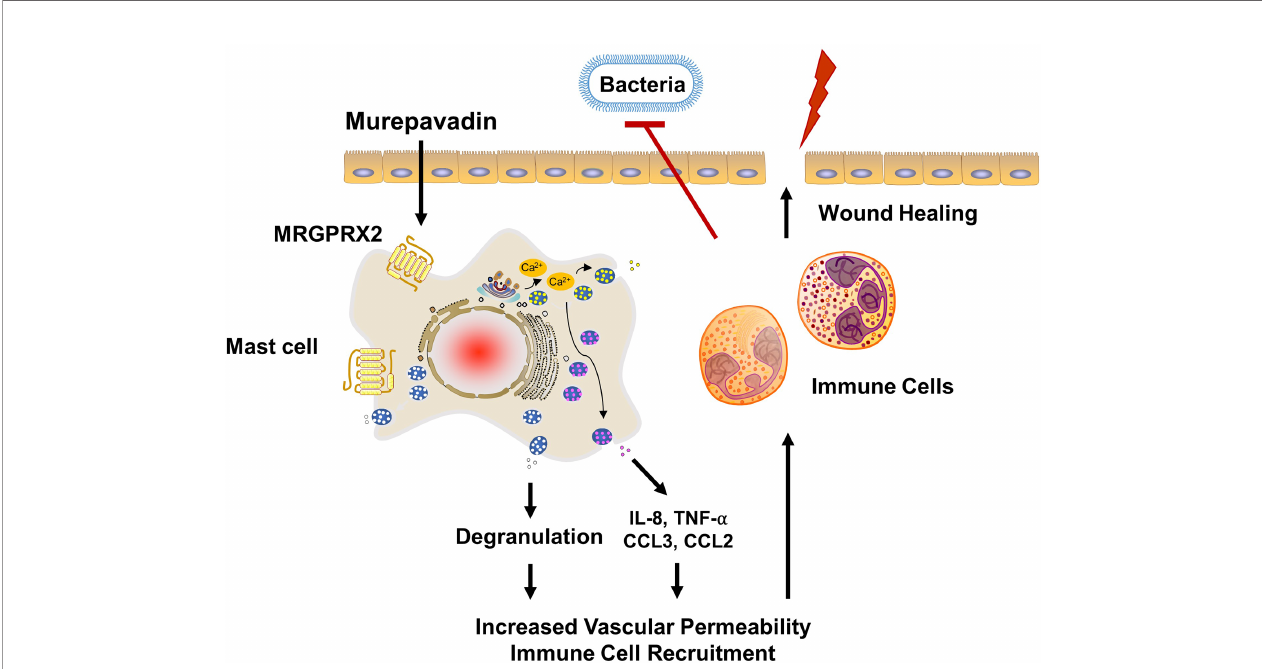
FIGURE 7 | Proposed mechanism of action of murepavadin/MRGPRX2-induced bacterial clearance and wound healing. Murepavadin activates MCs via MRGPRX2. An increase in intracellular calcium following murepavadin stimulation triggers MC degranulation and chemokine production (IL-8, CCL3, CCL2, and TNF- a ). These MC mediators induce immune cell recruitment and subsequently contribute to host defense and wound